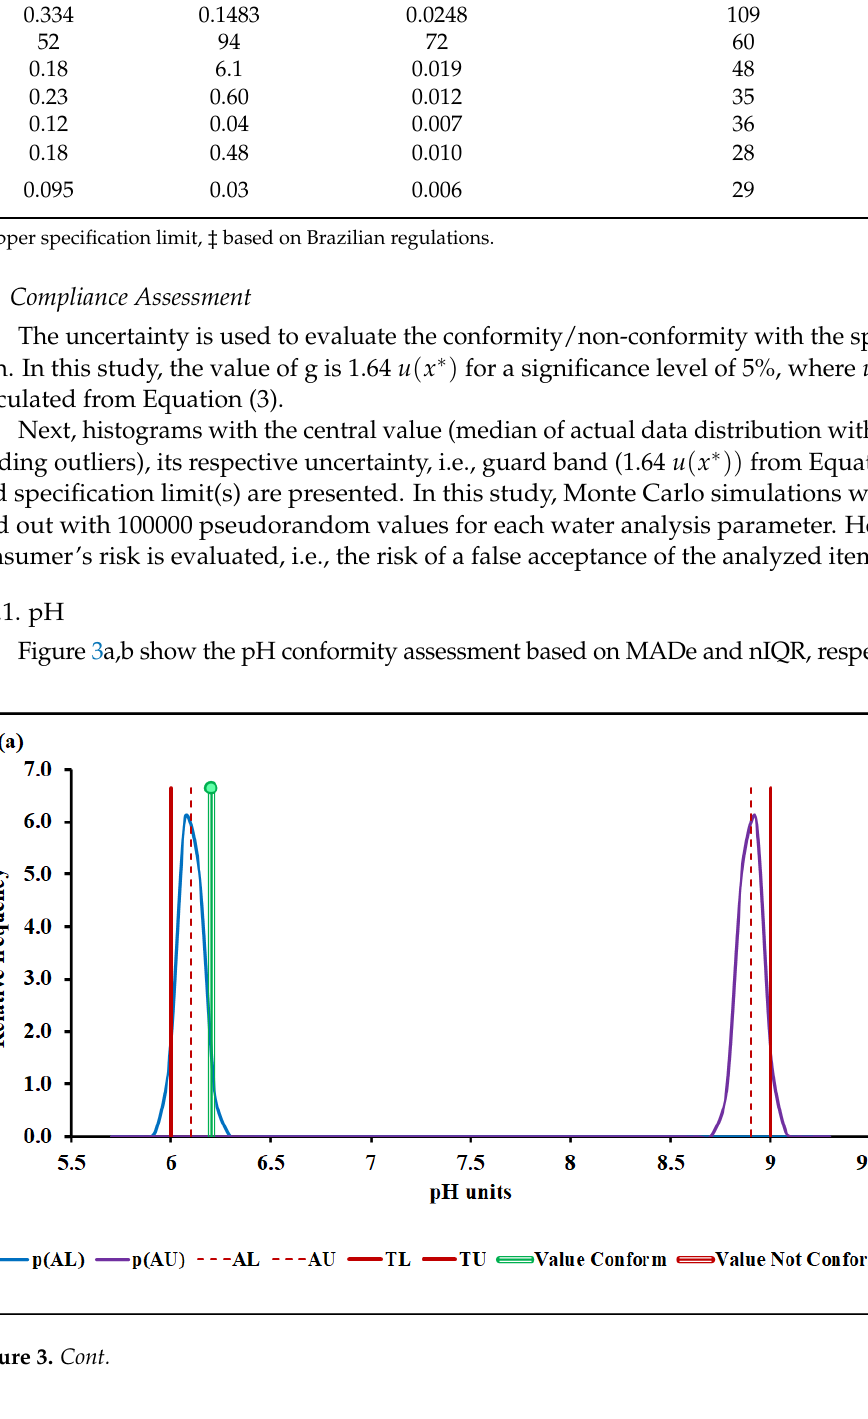
Table 2. Statistical results.